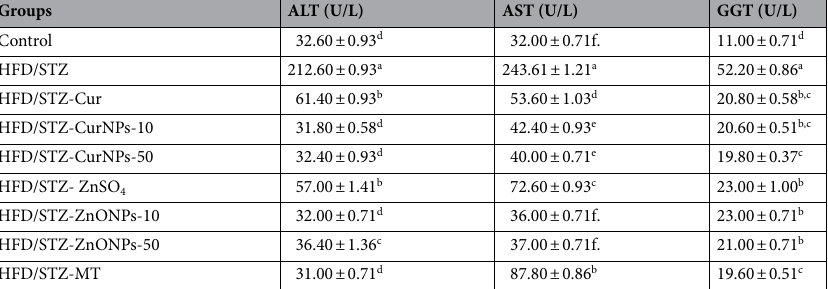
Table 4. Effect of CurNPs and ZnONPs administration on serum liver function enzymes (ALT, AST, and GGT levels) of STZ-induced diabetic and control rats. Values are expressed as mean ± SEM (n = 7), means for the same parameter with different letters in each column are significantly different (Tukey, p <